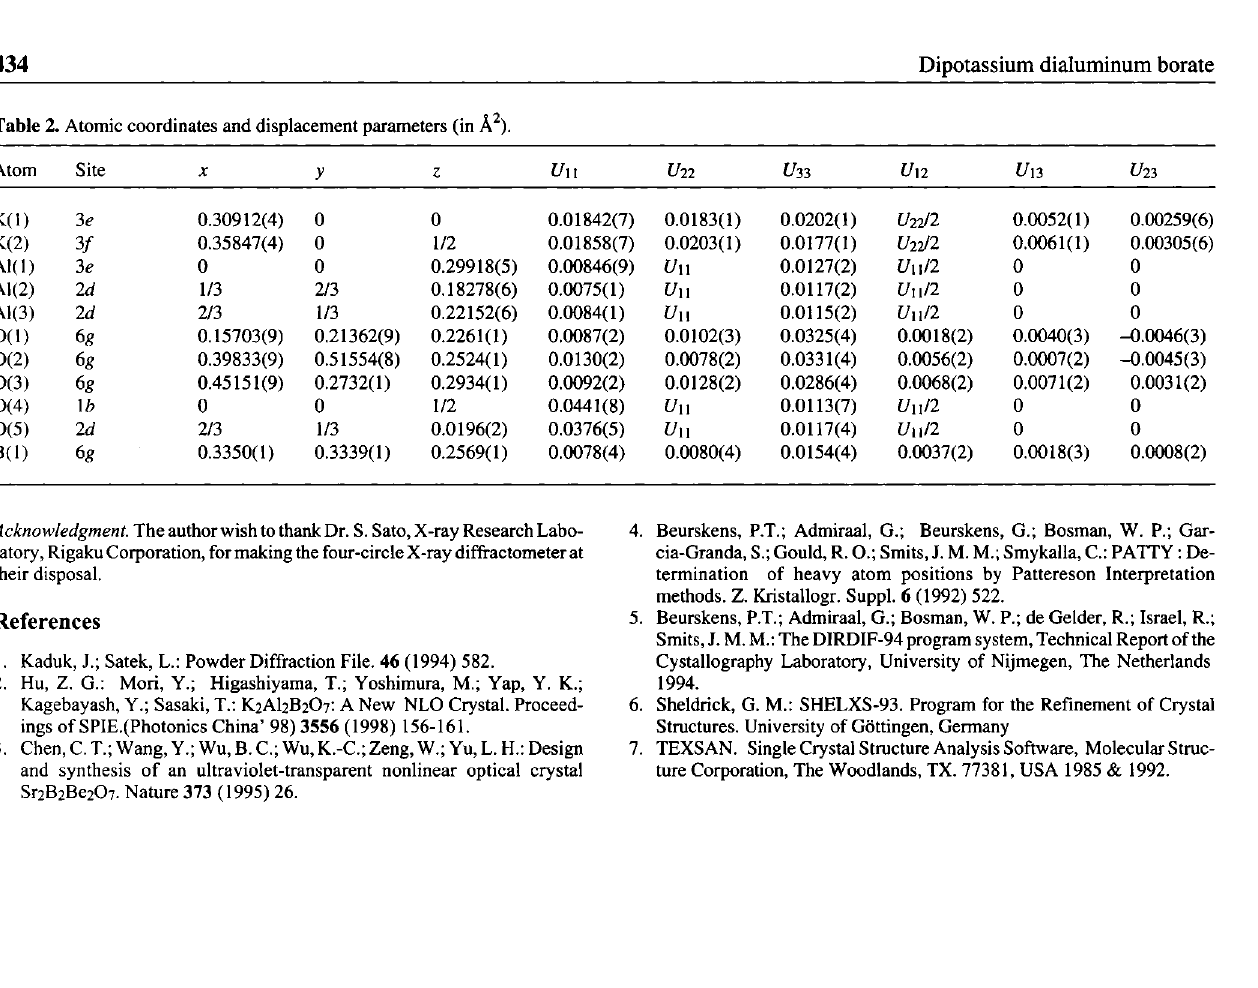
Table 2. Atomic coordinates and displacement parameters (in Ä 2